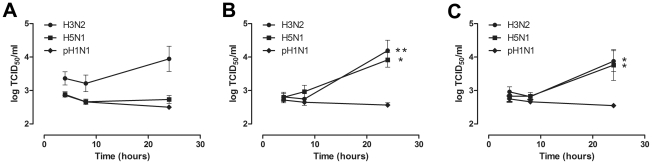
Virus production in alveolar macrophages and monocyte-derived macrophages after H3N2, H5N1 or H1N1 virus infection.Virus production of alveolar macrophages (AM) (a), macrophages cultured in the presence of human serum (MM) (b), and macrophages cultured in the presence of GM-CSF (GM-MM) (c), after infection with seasonal H3N2 virus, HPAIV H5N1 or pandemic H1N1 virus. Geometric mean titers were calculated from independent experiments; error bars indicate standard deviation. * indicates a statistical (p<0.05) difference. ** indicates a statistical (p<0.01) difference.